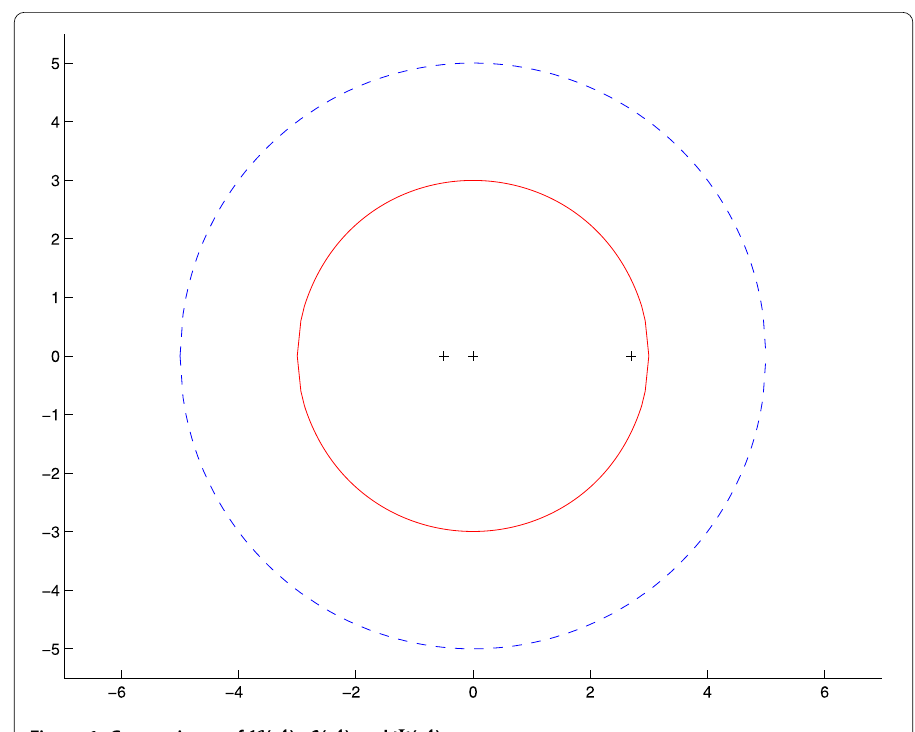
Figure 1 Comparisons of K ( A ), L ( A ) and (cid:2) ( A